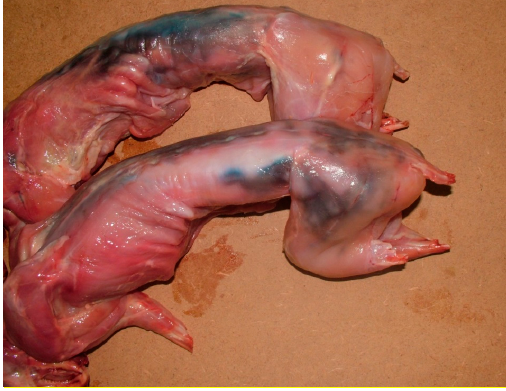
Figure 3. Chromatic alteration experimentally reproduced.